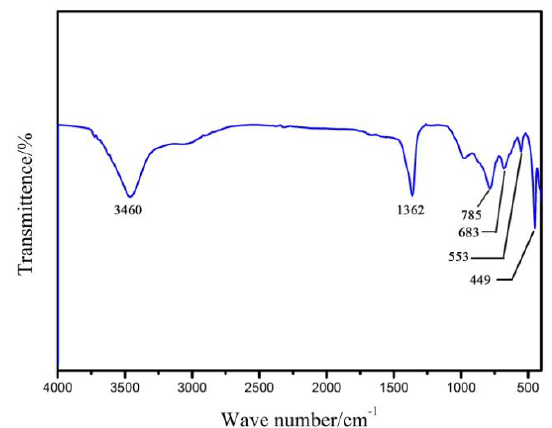
Figure 4. Infrared spectra of Mg 2 Al-CO 3 LDHs prepared by CO 2 as carbon sources.